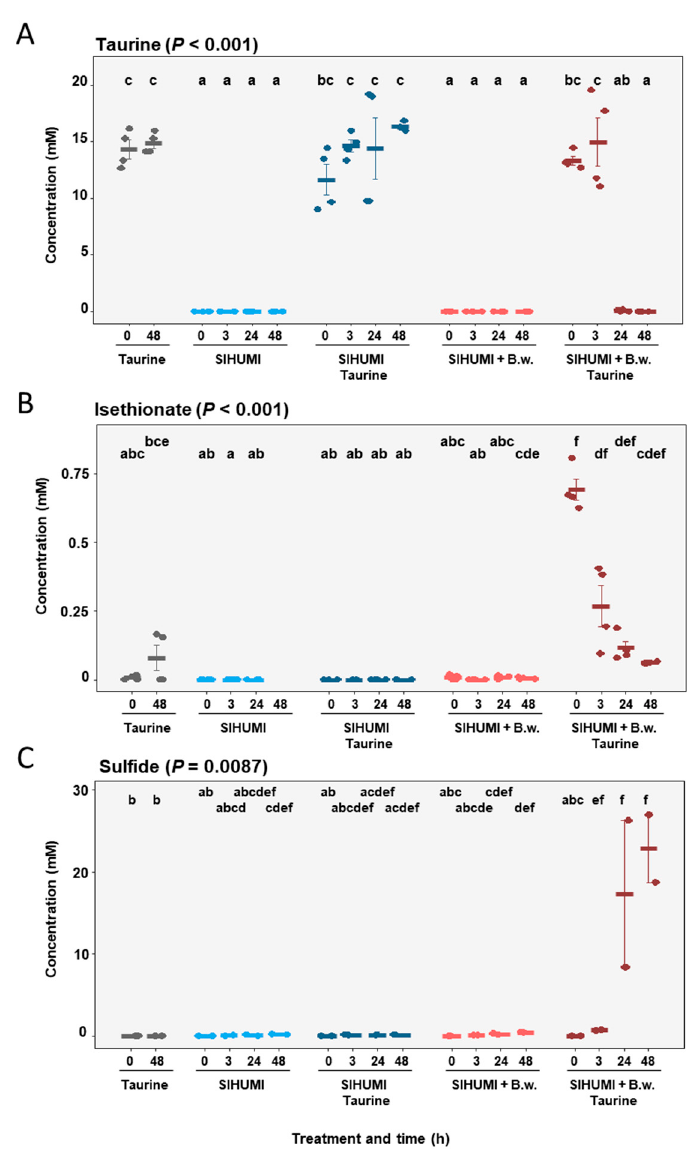
Figure 5. Mean concentrations of taurine ( A ), isethionate ( B ) and sulfide ( C ) at 0, 3, 24 and 48 h in substrate control with taurine, SIHUMI, SIHUMI with taurine, SIHUMI and Bilophila wadsworthia , and SIHUMI and Bilophila wadsworthia with taurine. Error is SEM. P calculated according to Kruskal – Wallis tests with post hoc Dunn tests. Differing letters depict significant differences between groups.